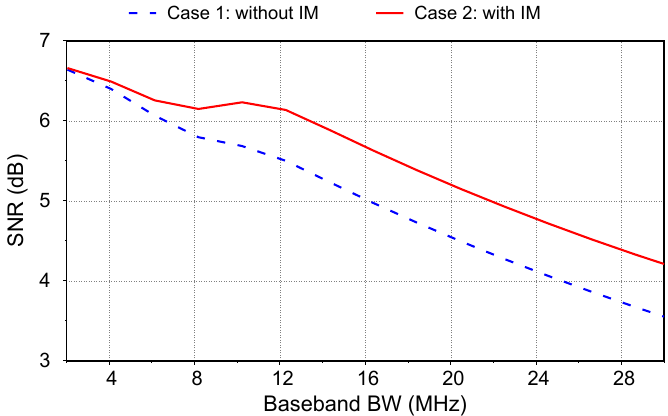
Figure 6. SNR as a function of baseband bandwidth considering or not the IM component. Case 1: without IM, Case 2: with